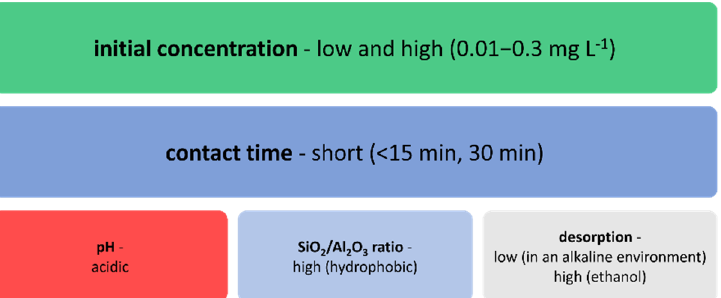
Figure 6. Factors influencing the sorption of diclofenac, ibuprofen, and ketoprofen on mesoporous materials: SBA-15, MCM-41, and TMS-SBA-15. materials: SBA-15, MCM-41, and